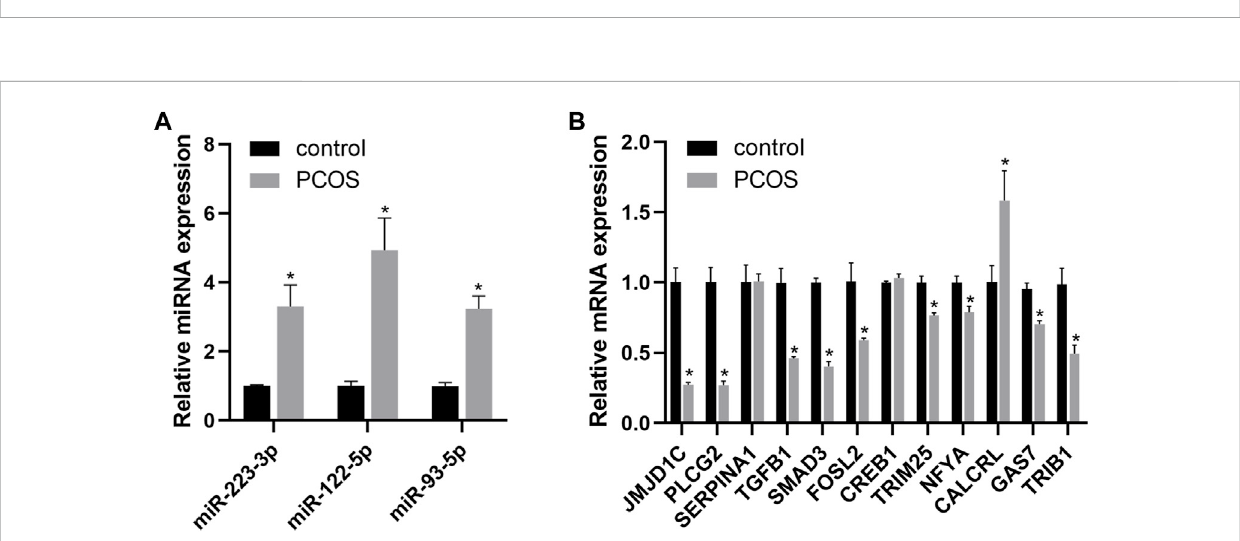
FIGURE 5 The qPCR veri fi cation results of three miRNAs (A) and twelve candidate target genes (B) in the rat model of PCOS. An asterisk indicates a signi fi cant difference between the two groups ( p p < 0.05) according to Student ’ s